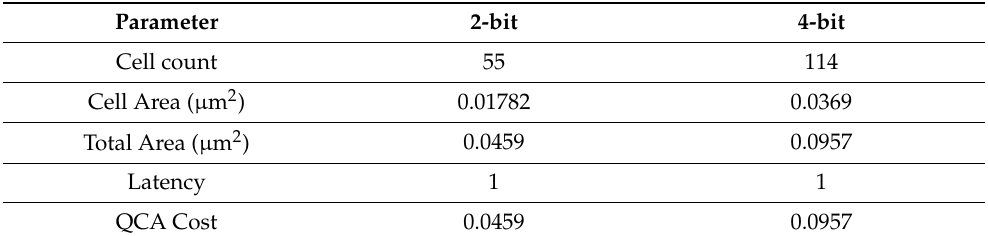
Table 1. Performance parameters of proposed PIPO shift registers.